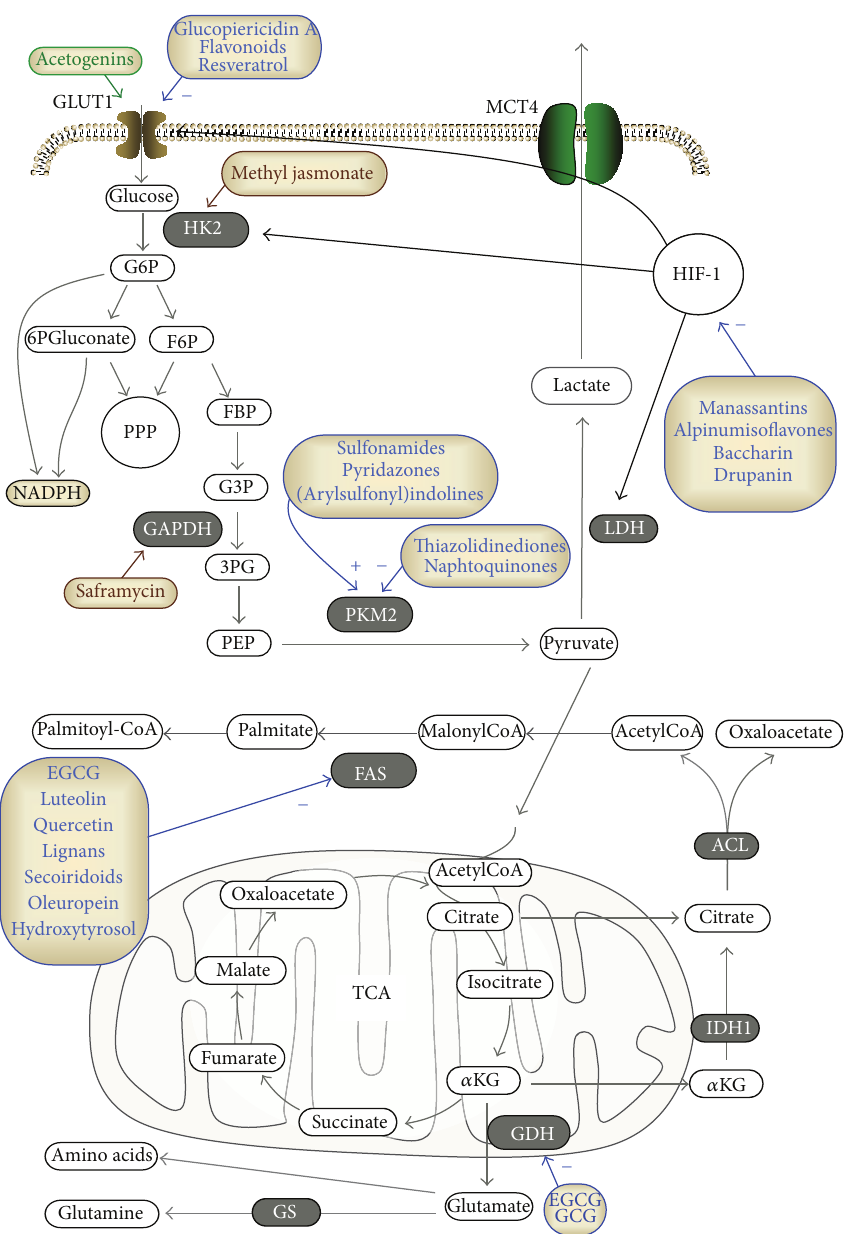
Figure 1: Targetable metabolic actors by natural compounds. A summary of the most relevant compounds affecting metabolic pathways of cancer cells. Many of these molecules correspond to natural compounds; alternatively, they are chemical structures found as active that may act as a template for the identification of promising natural compounds with similar activity. Molecules indicated in blue affect enzymatic activity (+ or − stands for activators or inhibitors, resp.); the ones in green affect the expression level of the targeted enzyme; the ones in brown affect nonmetabolic activities. Abbreviations: ATP citrate lyase, ACL; gallocatechin gallate, GCG; epigallocatechin gallate (EGCG); fatty acid synthase, FAS; fructose-6-phosphate, F6P; fructose-1,6-biphosphate, FBP; hypoxia-inducible factor 1, HIF-1; glucose-6-phosphate, G6P; glutamine synthetase, GS; hexokinase II, HK2; glyceraldehyde-3-phosphate, G3P; glyceraldehyde-3-phosphate dehydrogenase, GAPDH; glucose transporter, GLUT; glutamate dehydrogenase, GDH; 𝛼 -ketoglutarate ( 𝛼 KG); isocitrate dehydrogenase 1, IDH1; lactate dehydrogenase, LDH; nicotinamide adenine dinucleotide phosphate-oxidase, NADPH; pentose phosphate pathway; 3- phosphoglycerate, 3PG; phosphoenolpyruvate, PEP; pyruvate kinase isoform M2,